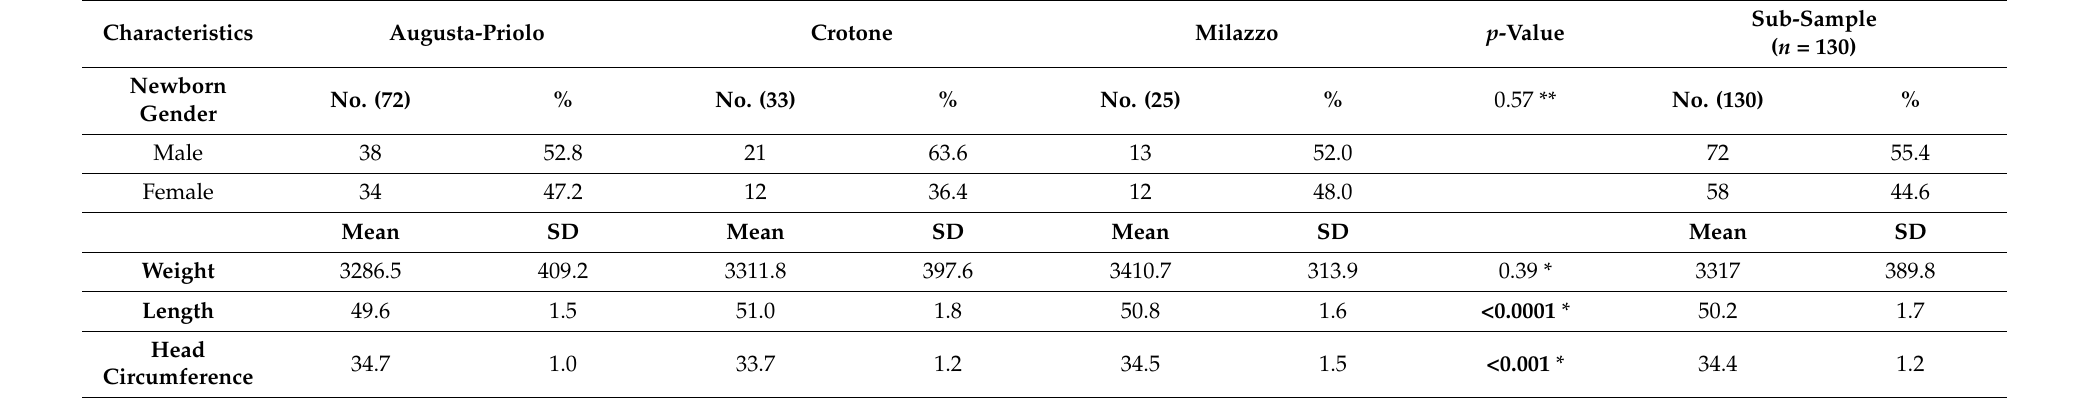
Table 6. Characteristics of the dropout newborns in the total subsample and in each NPCS: continuous variables are reported as mean ± SD, while categorical variables are reported as numbers and percentages. Significant p -values are in bold. For each categorical variable, in parentheses, the total number of responders is indicated.